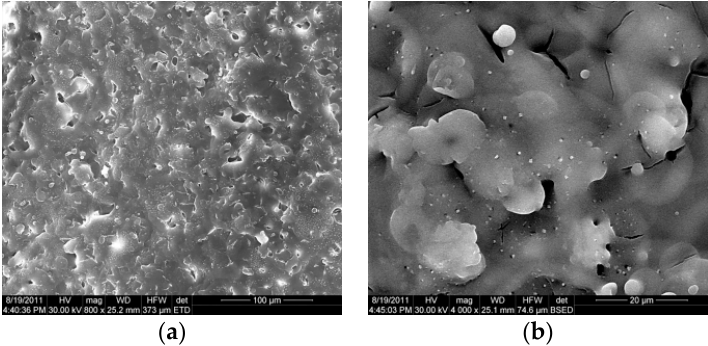
Figure 8. EDAX analysis of two different areas on the MXA pellet fracture.